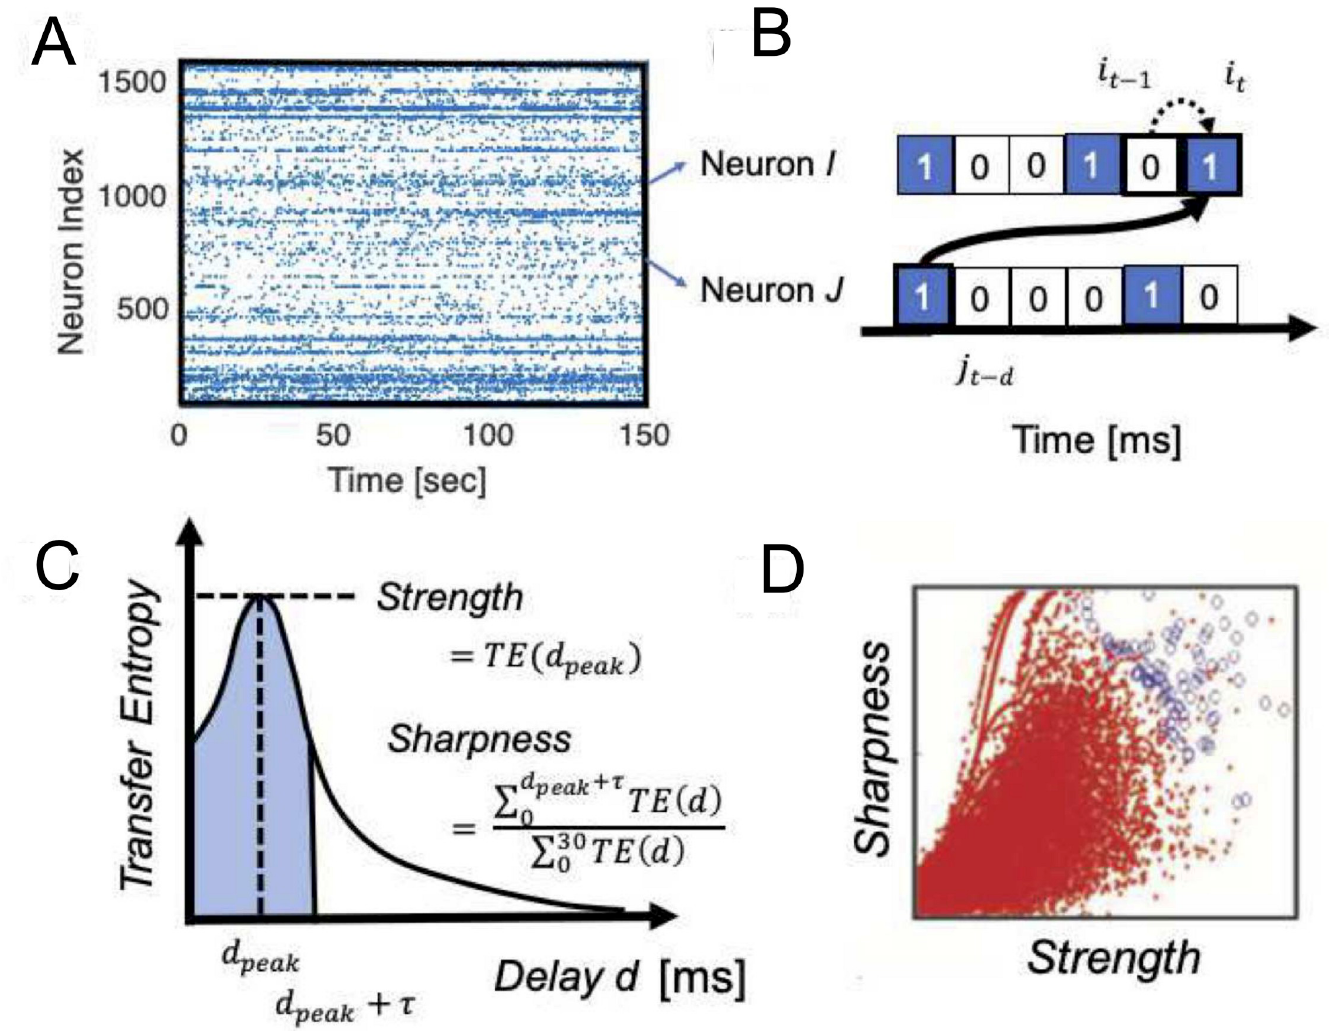
Fig 2. Effective connectivity definition: A A raster plot of neuronal spikes given after spike sorting analysis. B zoomed-in view of a pair of neurons, I and J. The transfer entropy used in this study specifically quantifies information flow sent from neuron J to I that takes delay d amount of time steps for the signal transmission, after conditioning on the past activity of neuron i at time t-1 . C Computing TE at different delay d, we can get TE ( d ), Transfer Entropy as a function of delay d. To characterize the TE ( d ) in terms of strength and sharpness of connections, we characterized two variables shown in this panel. τ is 4 ms in this study. The value was selected as the standard deviation of the fitted function to the average of TE ( d ) for all neuron pairs. D The Strength and Sharpness are mapped onto the two dimensional space and we selected connected pairs of neurons shown as blue circles by comparing with the distribution of shuffled spike data (red dots).